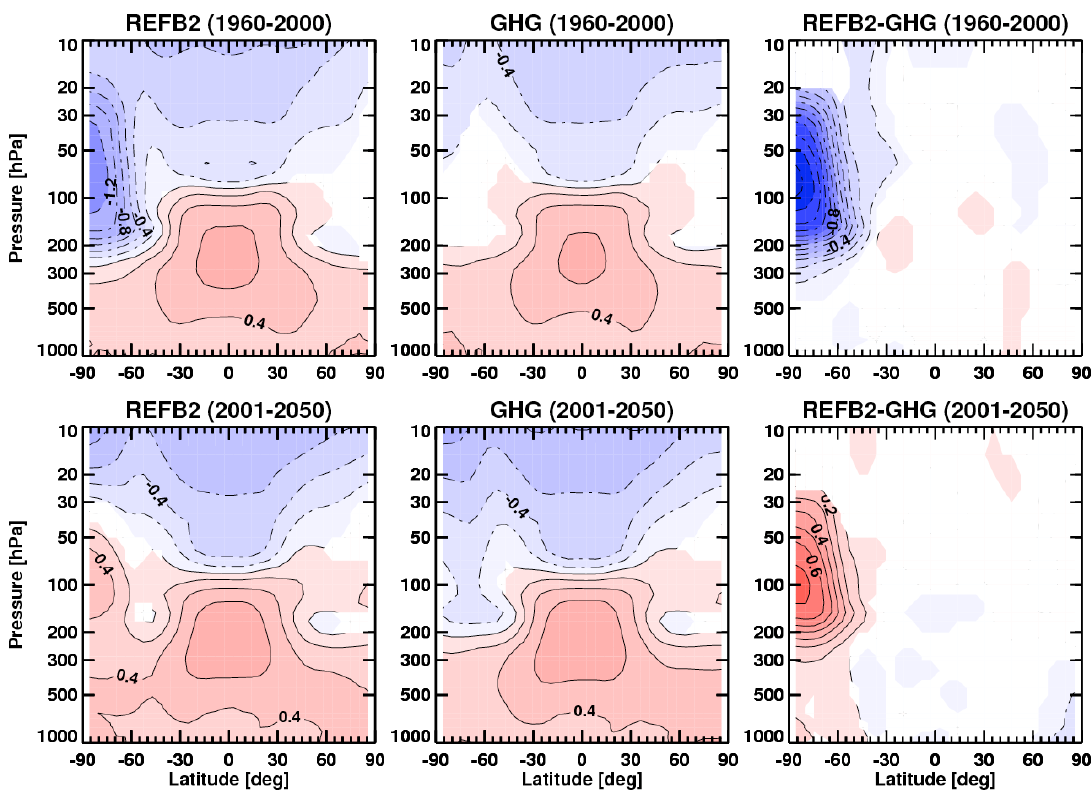
Fig. 1. Annual and zonal mean temperature trends for 1960–2000 (top) and 2001–2050 (bottom): REF-B2 (left), GHG (middle), and REF-B2 minus GHG (right). Contour intervals are 0.2 and 0.1Kdecade − 1 in the two left columns and right columns, respectively, with red denoting positive values and blue negative. Only trends that are significant at the 95% level are shown.